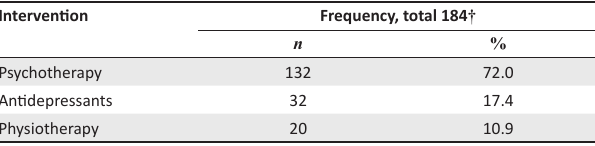
TABLE 10: Management.